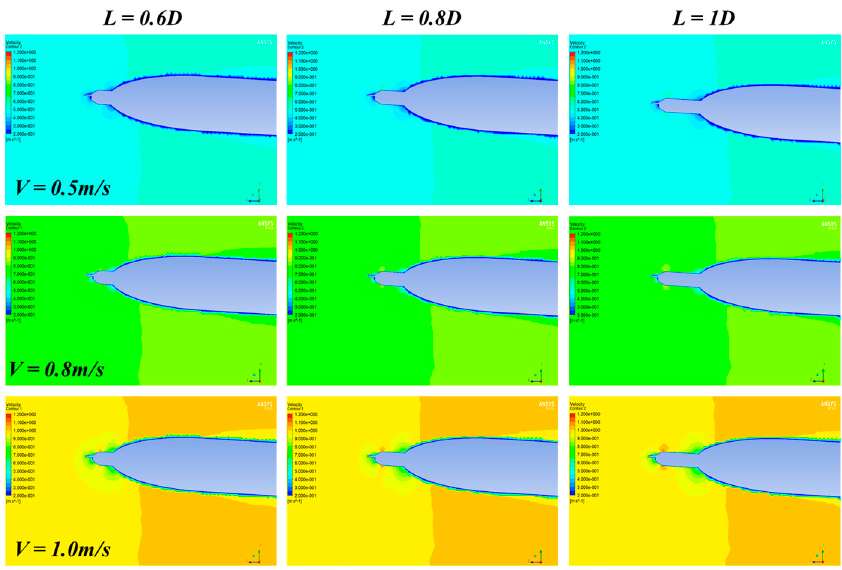
Figure 5. Velocity vectors of the turbulence AUV under various models with 3° AOA. The rows represent the same velocity of the flow field and the columns represent the same distance X.